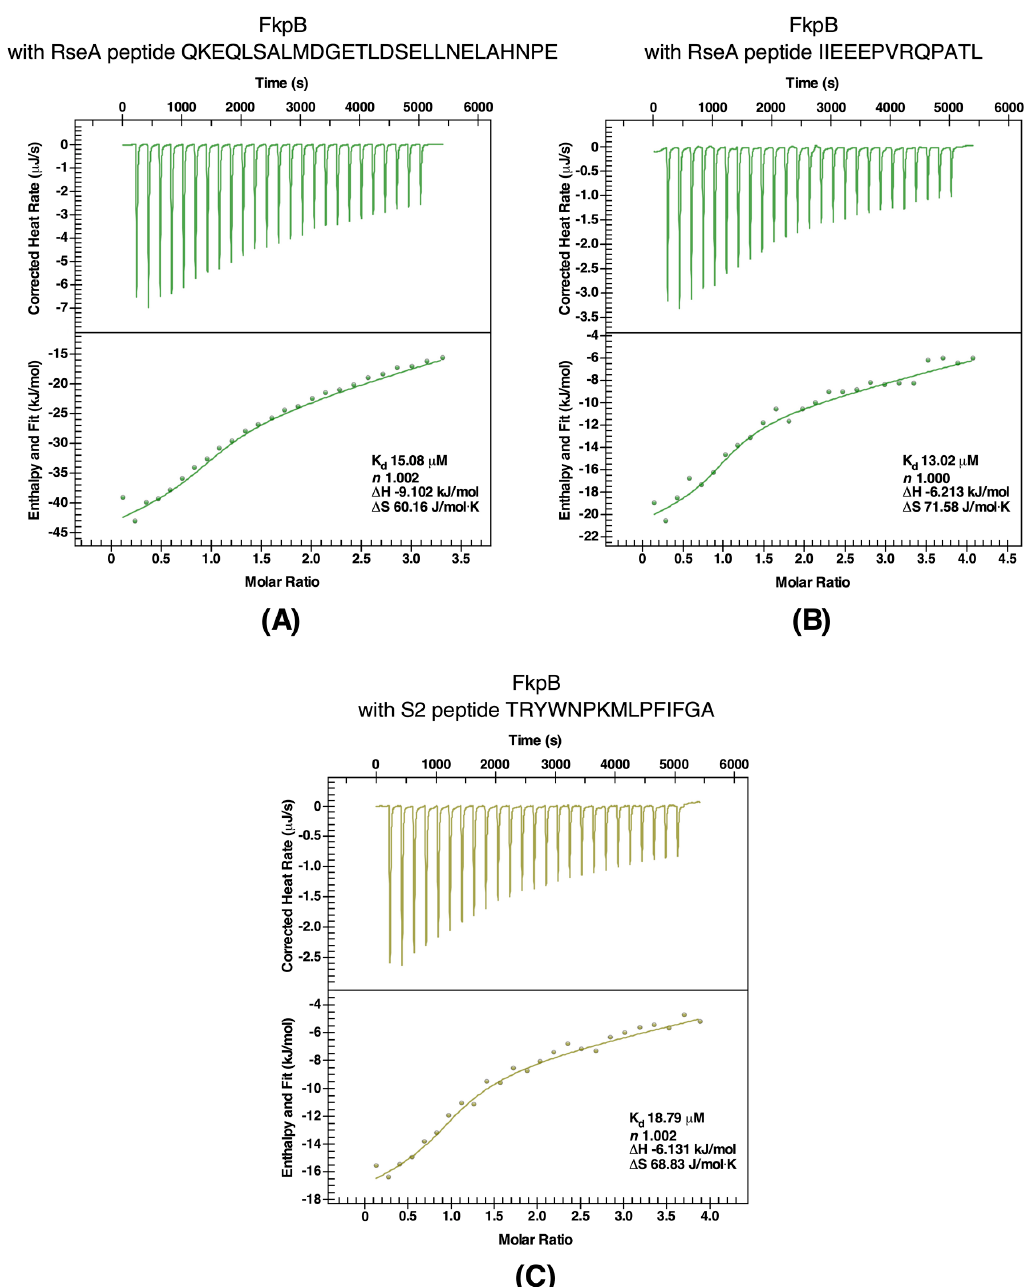
Figure 8. Quantification of binding affinity of FkpB with peptides from RseA (Panel A and B ) and the peptide from the S2 ribosomal protein (Panel C ). Heat rates and fit for ITC experiment, where FkpB is injected into above ‐ mentioned peptides. The calculated stoichiometry ( n ) and dissociation constant (K d ) are indicated in insets. I have made capital Panel to be consistent.